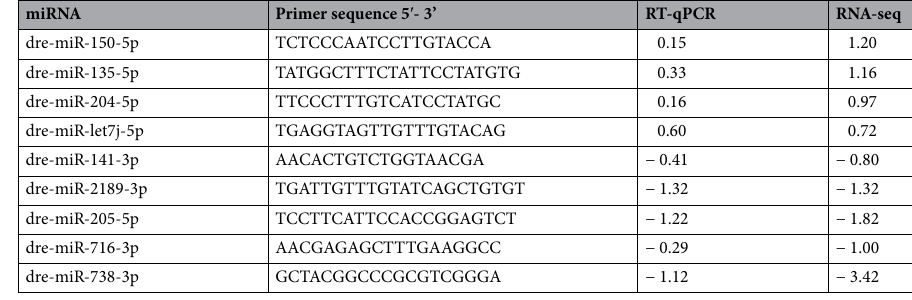
Table 8. miRNA primers used for RT-qPCR validation (CLC-Workbench v6.0). RT-qPCR values are given as log2 fold change (FC) of the expression in generation F 1 from exposed parents (F 1 -γ) relative to generation F 1 from control parents (F 1 -C). RNA-seq values are given as log2 FC and derived from differential expression analysis using edgeR (v3.24.3, Bioconductor) by pairwise comparison between F 1 -γ and F 1 -C group. Spearman’s correlation coefficient = 0.7667 (p = 0.02, confidence interval 95%, alfa <